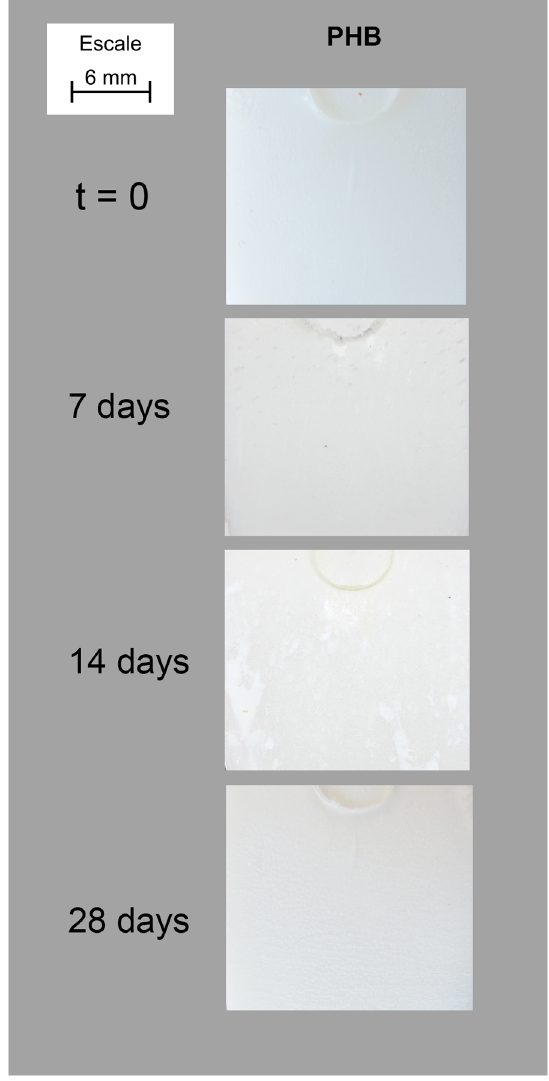
Figure 1. Evolution of the surface of plain ‐ PHB samples inside Xenotest chamber.